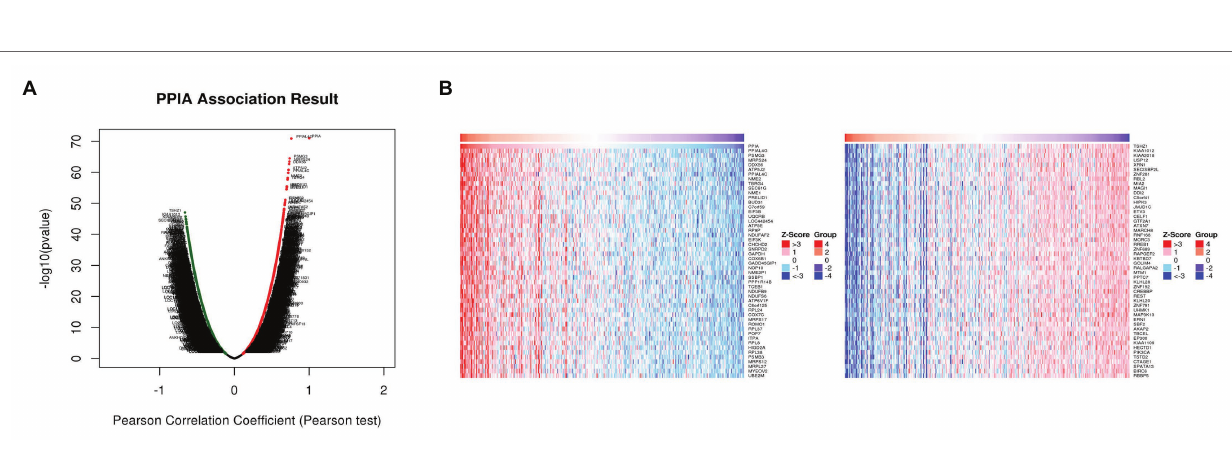
FIGURE 4 | MHCC-97H was detected by RT-qPCR. (F) Overexpression of PPIAP22 in MHCC-97H resulted in decreased expression of miR-197-3p. (G) Overexpression of PPIAP22 in MHCC-97H resulted in increased expression of PPIA. (H) The expression of miR-197-3p in MHCC-97H transfected with negative control (NC) or miR-197-3p inhibitor. (I) The expression of PPIA was increased in the miR-197-3p inhibitor group. (J) The expression of PPIA was decreased in the miR-197-3p mimic group. (K) The expression of miR-197-3p in MHCC-97H transfected with negative control or miR-197-3p mimic. PPIAP22, peptidylprolyl isomerase A pseudogene 22; PPIA, peptidylprolyl